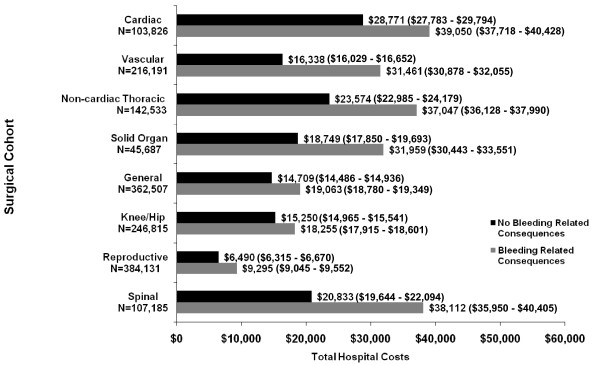
Mean Total Adjusted1 Hospital Costs (95% CIs) in 2007 $US by Surgical Cohort.